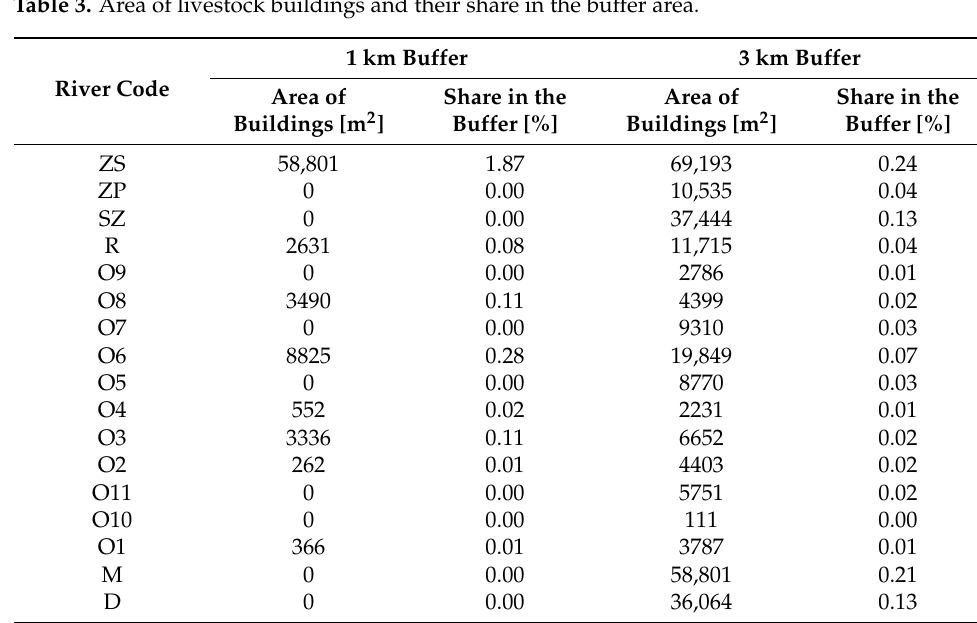
Figure 6. The use structure of catchments located in the studied sites (based on MPHP10k and BDOT10k, site codes are provided in Table 1). Table 3. Area of livestock buildings and their share in the buffer